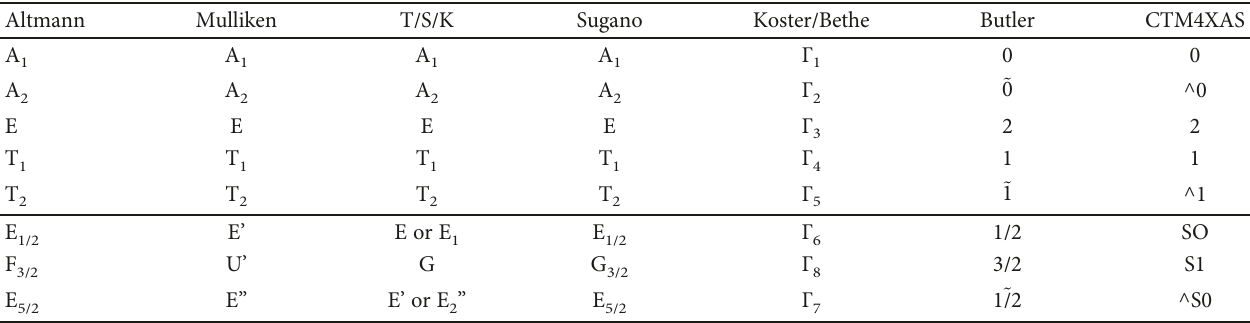
Table 6: Summary of the di ff erent notations in O symmetry. T/S/K: Tanabe/Sugano/Kamimura, though Sugano also uses a variation of this h notation as shown. The CTM4XAS program uses mostly the Butler notation, though the .ora- fi le translation is listed for ease of use.